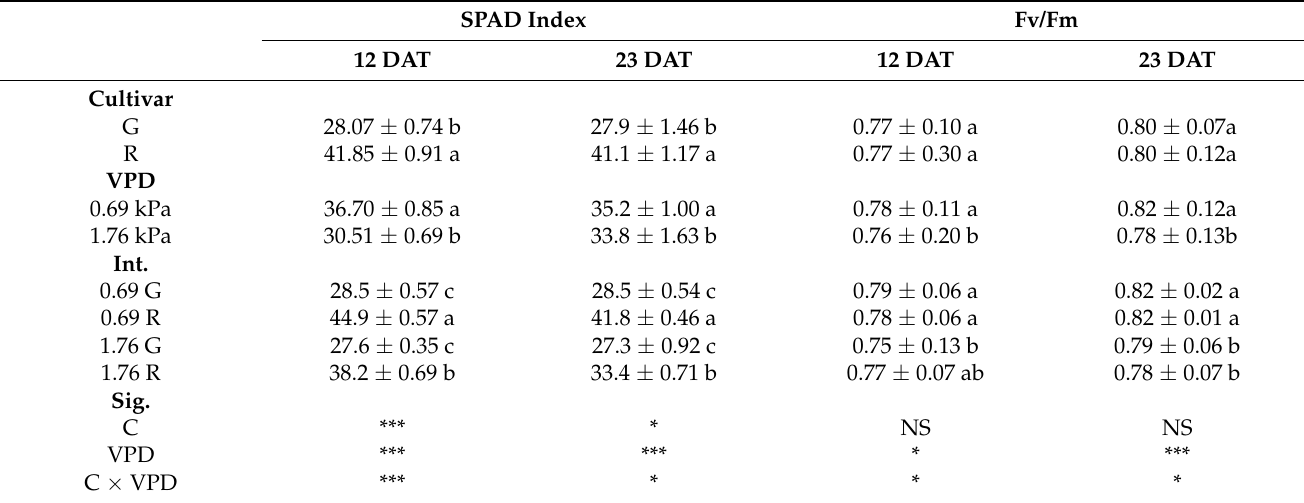
Table 5. Soil Plant Analysis Development (SPAD) index and Fv/Fm in leaves of green (G) and red (R) lettuce plants grown under the two VPD levels (0.69 and 1.76 kPa) at 12 and 23 DAT (days after